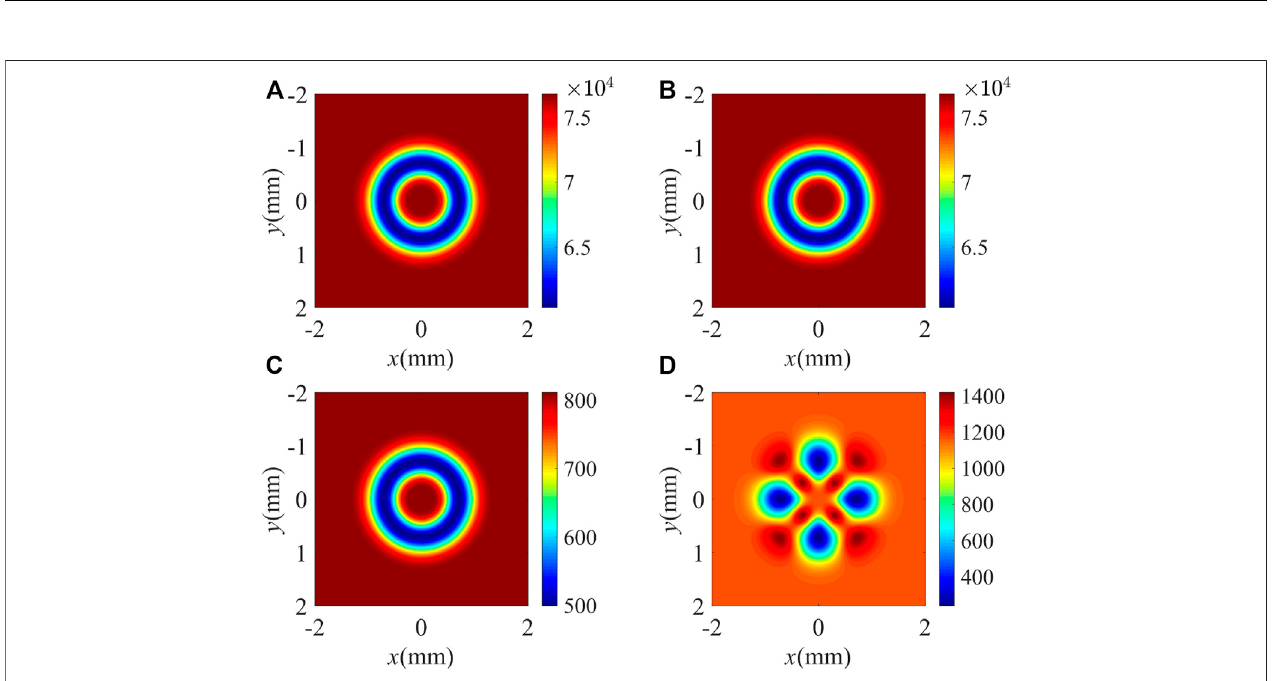
FIGURE 3 | (A,B) Real and (C,D) imaginary parts of the dispersion relation K . (A,C) without including electronic continuum: γ 3 l = γ 4 l = 1 meV and p = 0; (B,D) with including electronic continuum: γ 3 l = 1.58 meV and γ 4 l = 1.50 meV and p = 0.83. Other parameters are the same as in Figure 2